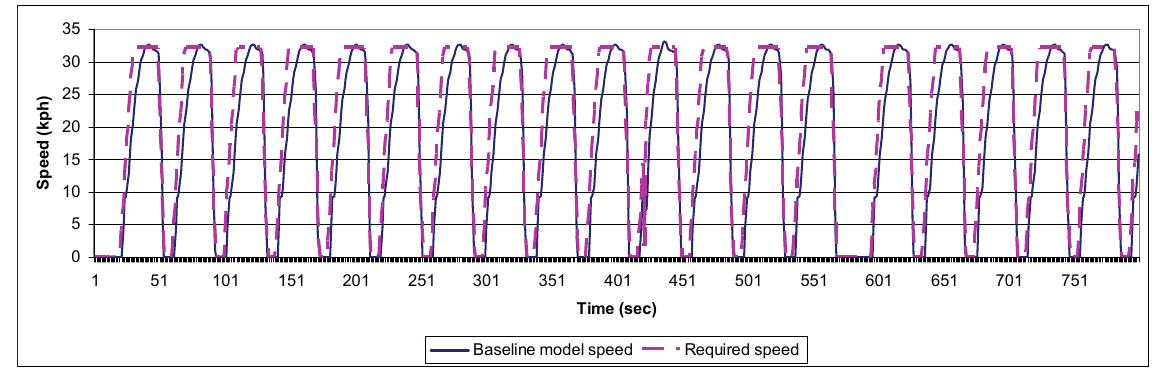
Figure 6. Comparison of modeled and required speed for baseline transit bus model.